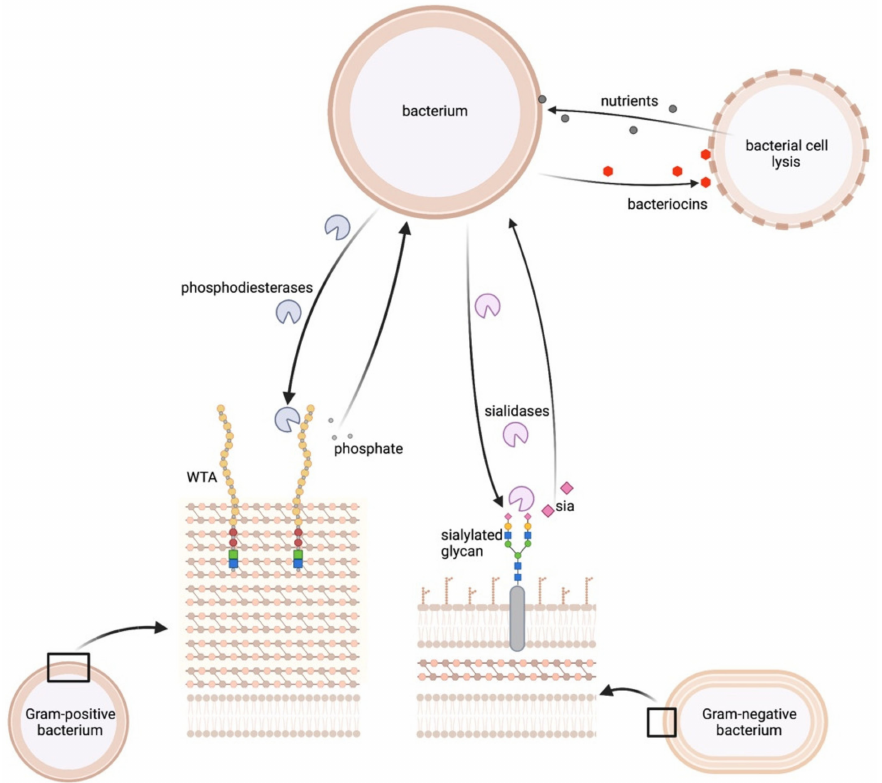
Figure 3. Microbiome members as a source of nutrients for other bacteria. Bacteria can degrade surface-exposed molecules of other bacteria and use them as nutrient sources. e.g., wall teichoic acids (WTA) can be degraded releasing glycerol-3-phosphate. Sialic acid (sia) can be acquired by degrading sialylated glycans. This figure was created with